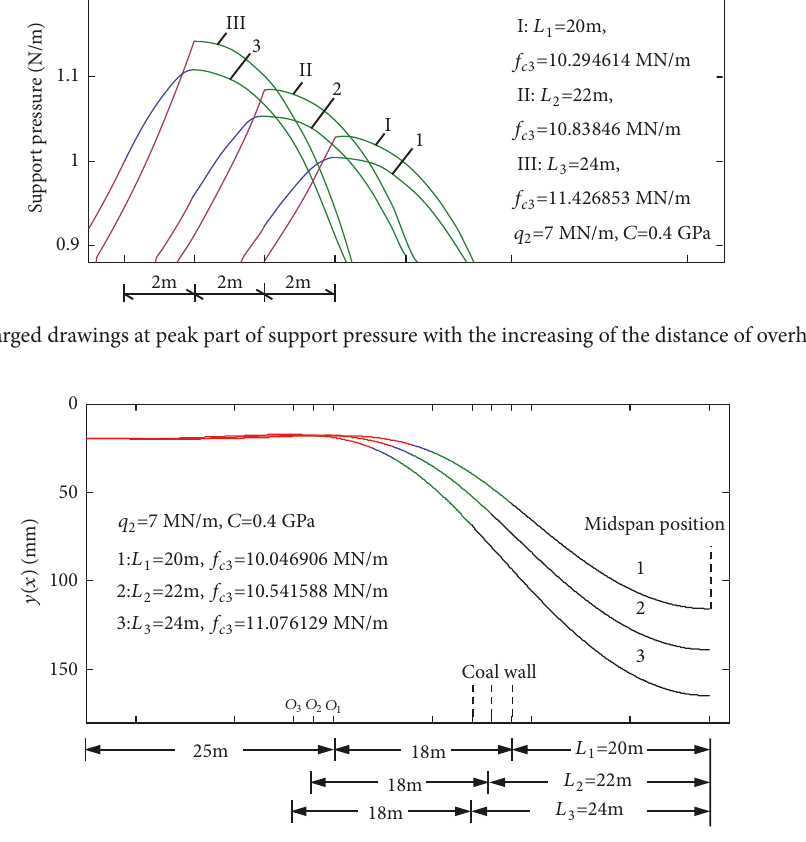
Figure 12: Deflection curves of rock beam with the increasing of the distance of overhang